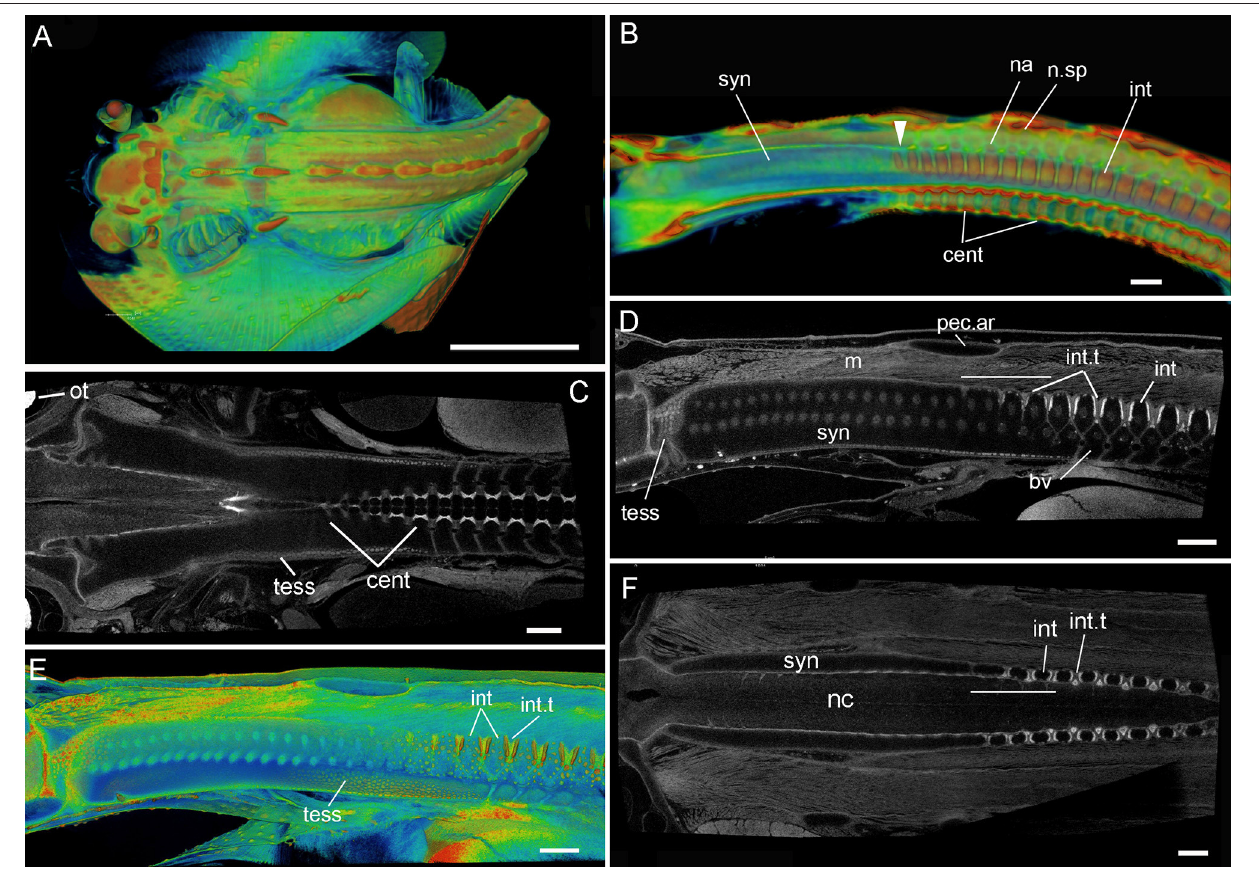
FIGURE 5 | Leucoraja erinacea , st. 33 (BMNH 2018.9.26.3), PTA staining, 3D rendered µ CT scans, false colored (A,B,E) grayscale (C,D,F) . (A) Dorsal view of individual; (B) virtual sagittal section showing internal morphology of synarcual and more posterior vertebrae; (C,F) dorsoventral virtual section through synarcual; (D,E) virtual sagittal section showing internal morphology (with respect to vertebral column, cartilages = black spaces; intervertbral tissue = light gray, mineralization = white). Abbreviations as in Figures 1 – 4 , as well, n.sp, neural spines. Scale bars: (A) = 1cm; (B) = 1mm; (C–F) = 500